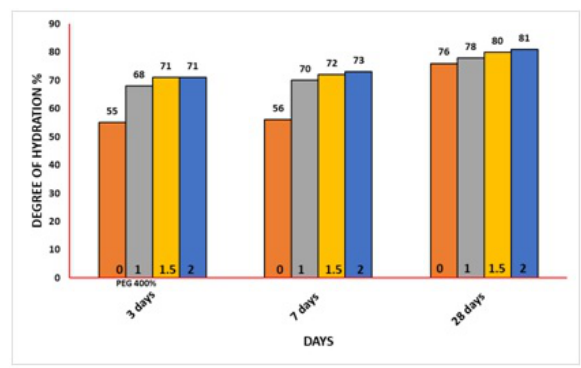
Fig. 5. Degree of Hydration Values at 0.55 Water-Cement